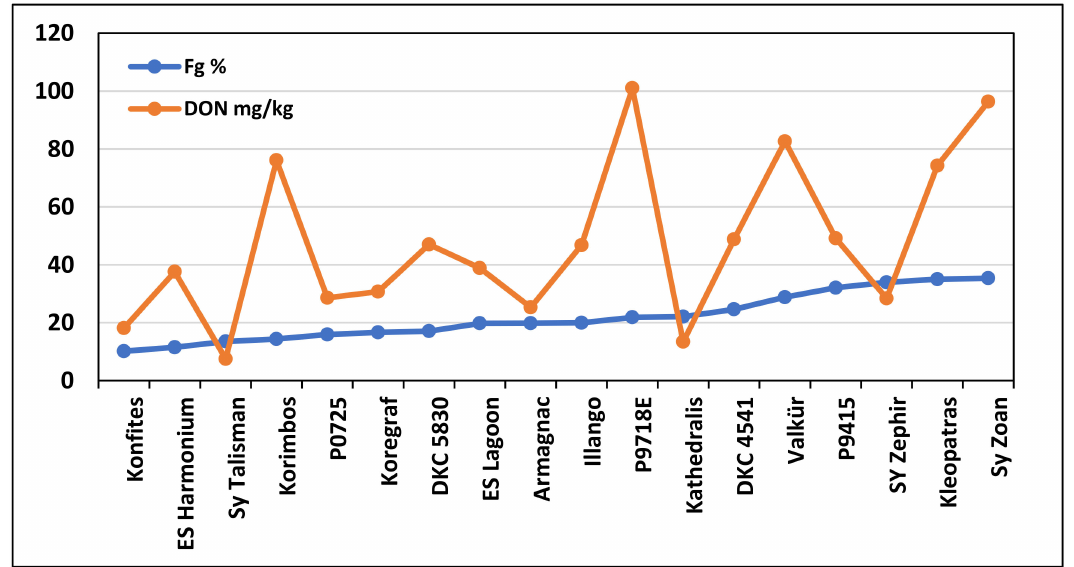
Figure 4. F. graminearum ear rot and DON production in the commercial hybrids following artificial inoculation (Szeged, 2019–2020). The variance can be found for each genotype in Table